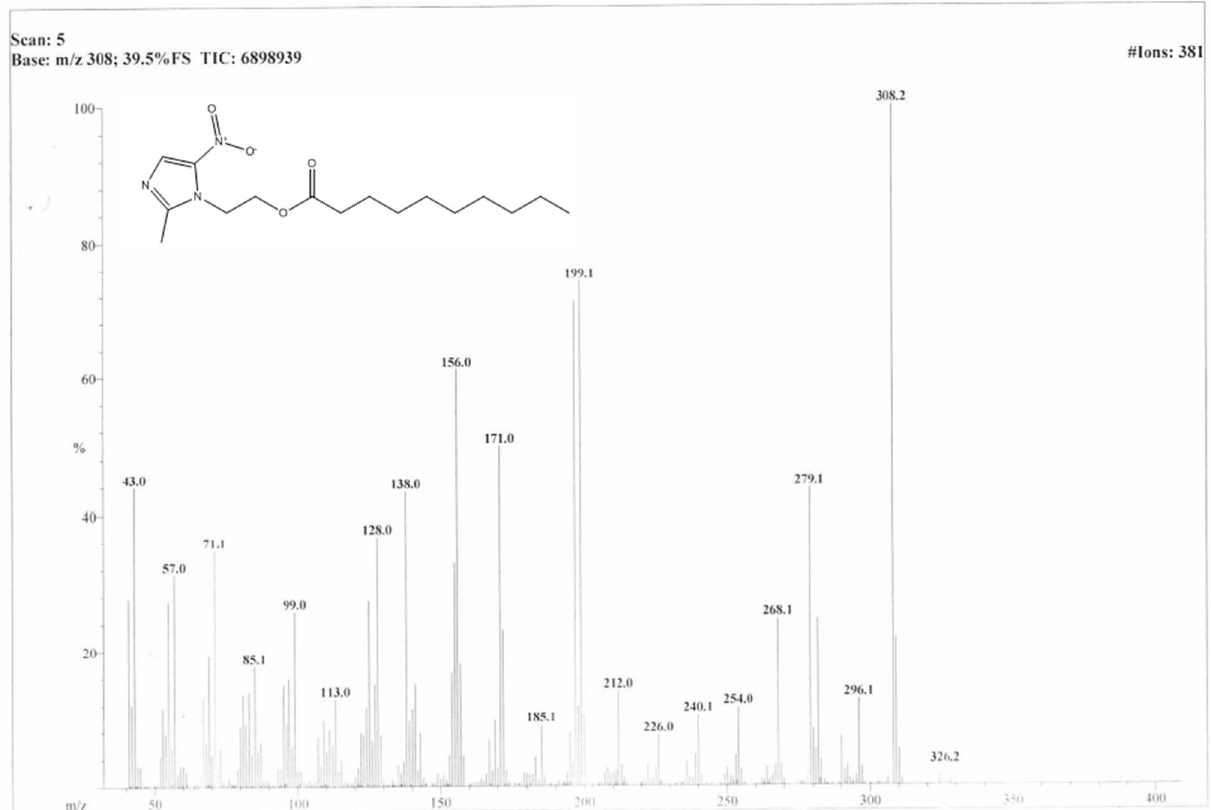
Figure 1. Mass spectra of “DC-Met-10”.